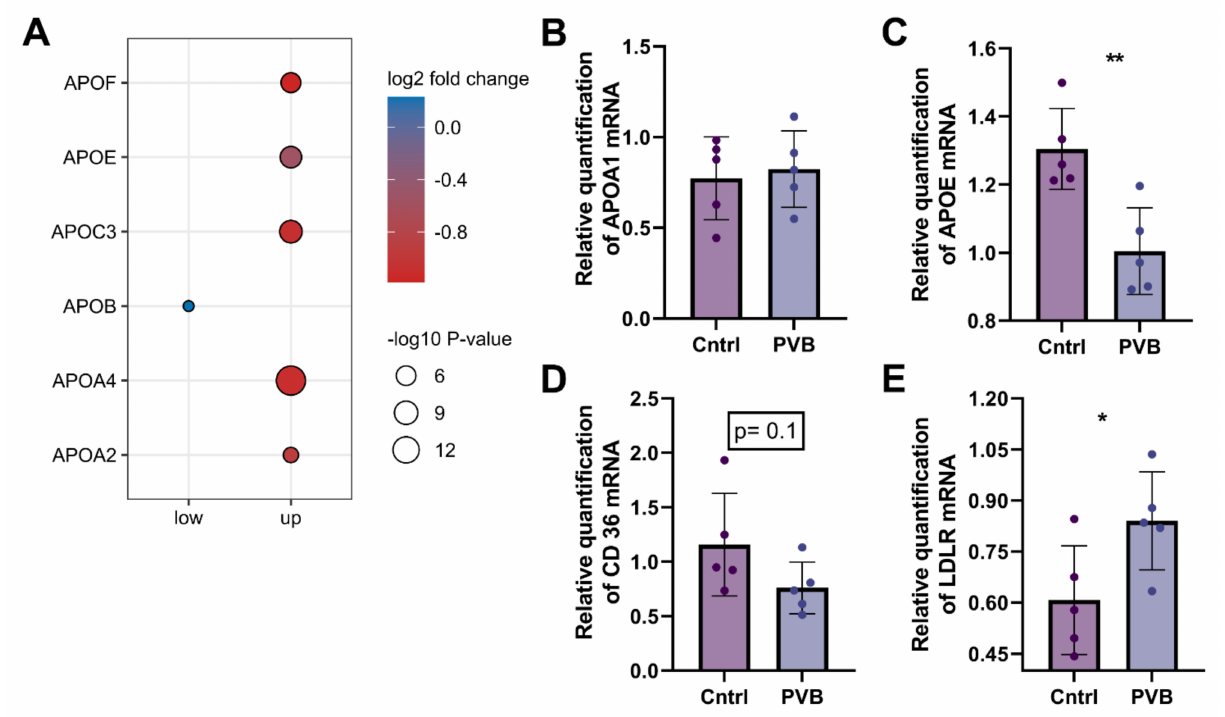
Figure 7. Fatty acid uptake pathway in the upper lobe at the protein and mRNA level. ( A ) Protein abundance of apolipoproteins that were significantly changed (Benjamini–Hochberg corrected p - value ≤ 0.05) between PVB compared to Cntrls in the upper and lower lobes are depicted as dots. n = 6 per group. ( B – E ) mRNA level of APOA, APOE, CD36 and LDLR, respectively, are expressed relative to the mean expression of the sham animals (values are mean +/ − SEM. * p < 0.05, ** p < 0.01 Students’s t -test n = 5 animals per